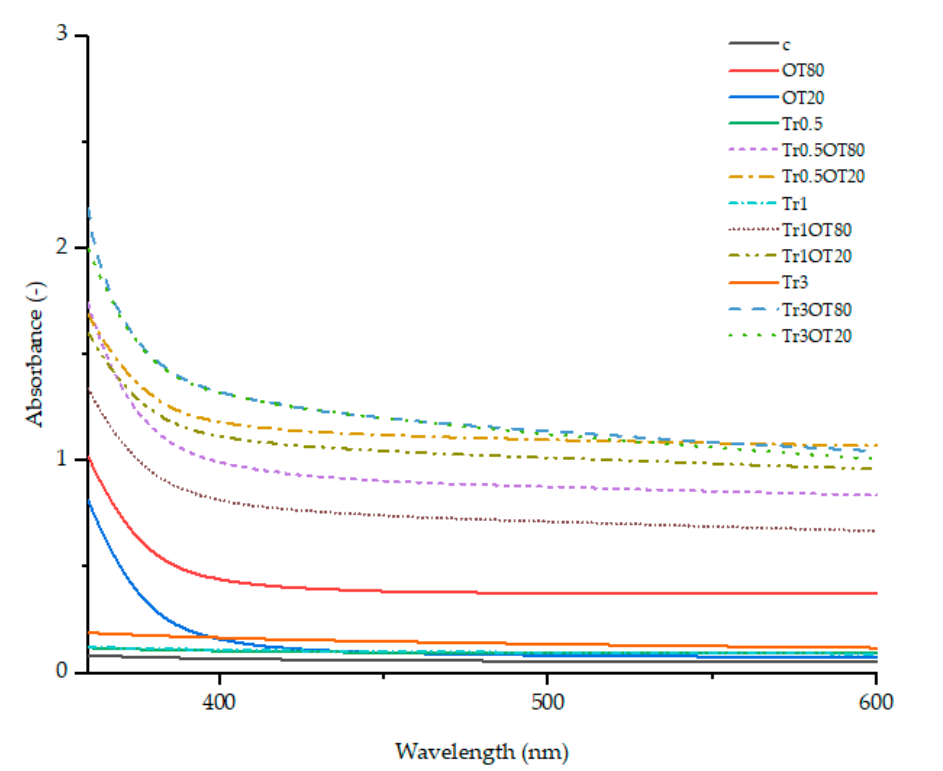
Figure 1. UV-Vis spectra of films with the addition of 0.5 g κ -carrageenan.